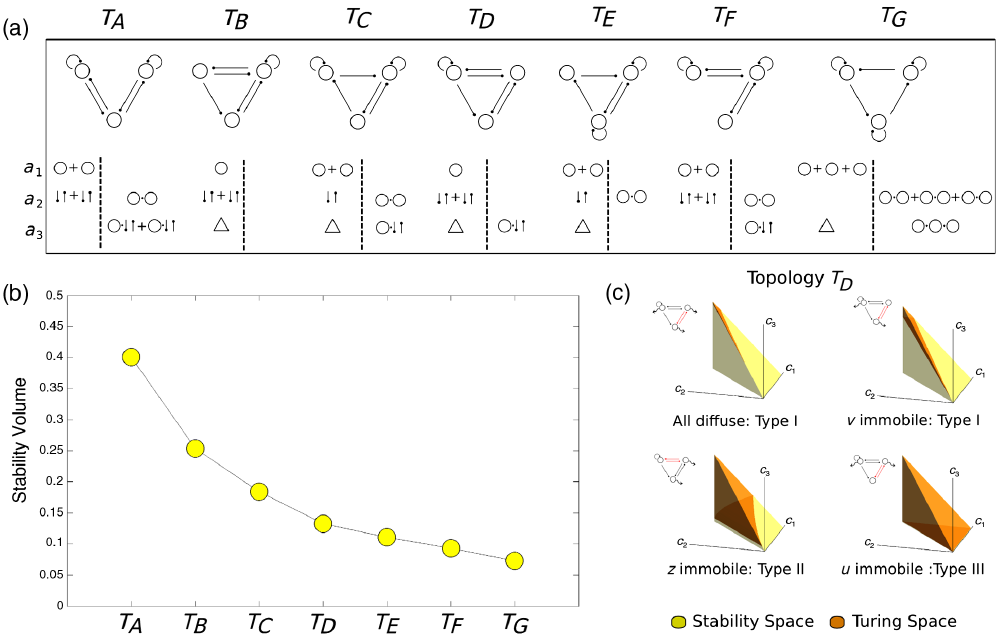
FIG. 5. (a) Seven topological families contain all minimal three-node Turing networks. For each family, the characteristic distribution ð 0 Þ is shown at the bottom. (b) Volume of the stability space of the three-node topological of cycles and l -subgraphs that form a R k families. For all Turing networks within a family, the stability space is the same. (c) Variation of the Turing space for T all nodes diffuse (in the top left panel, fine-tuning of kinetic parameters is necessary) or one of the nodes is immobile (for the rest, fine- tuning is not required and d ¼ 1 . 5 in all cases). Volumes of stability and Turing spaces are calculated following the method detailed